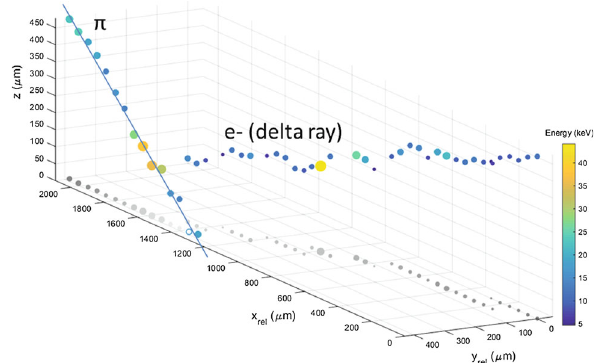
each reconstructed point to the fit curve can be described by a gaussian distribution with a width of σ xyz = 54 . 5 µ m, indi- cating the 3D tracking precision. When sampling the energy losses along the particle trajectory in Fig. 13d, a peak due to a delta ray motion towards either of the contacts is observed. As only 2D projections of each track are measured, the delta ray track is masked by the primary track, so that its trajectory cannot be